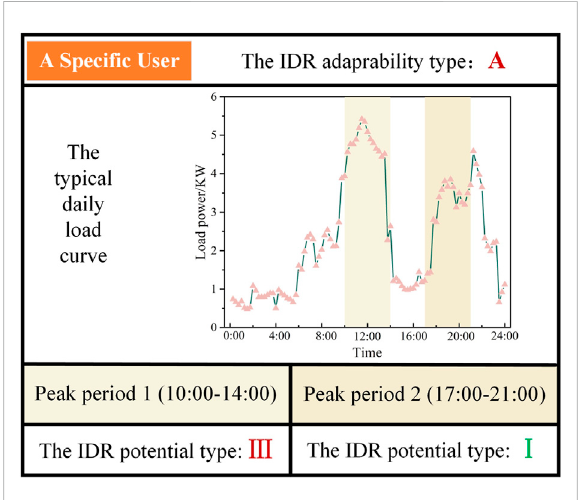
FIGURE 9 The portrait of the IDR adaptability and the portrait of the IDR potential for a speci fi c